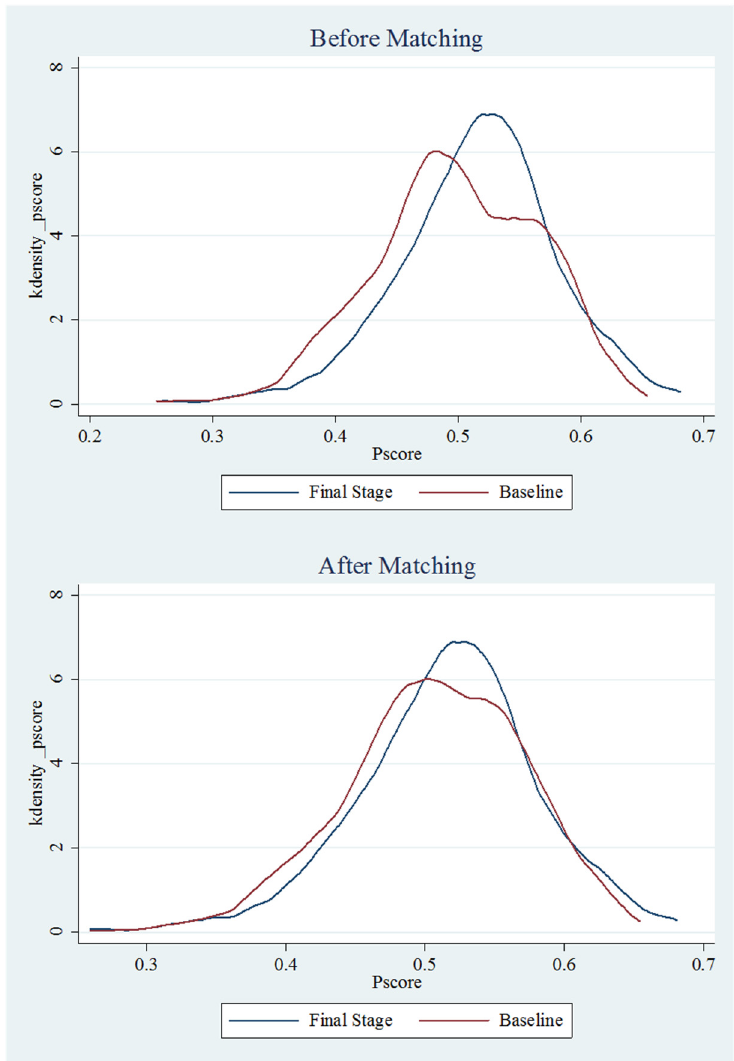
Figure 2. Overlay of Kernel density distributions of baseline and final stage propensity scores before and after propensity score matching.